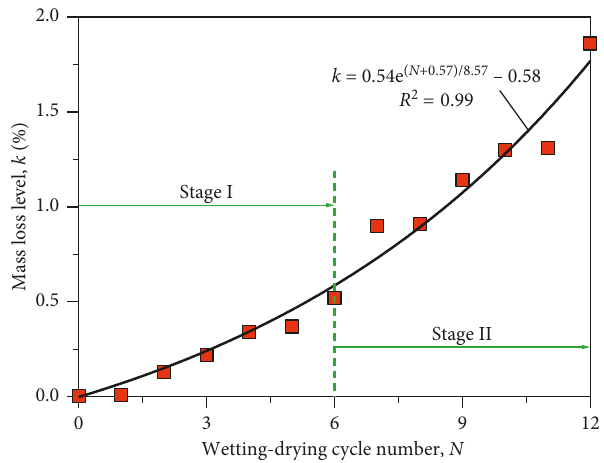
Figure 5: Variation in mass loss level with different wetting-drying cycle number.